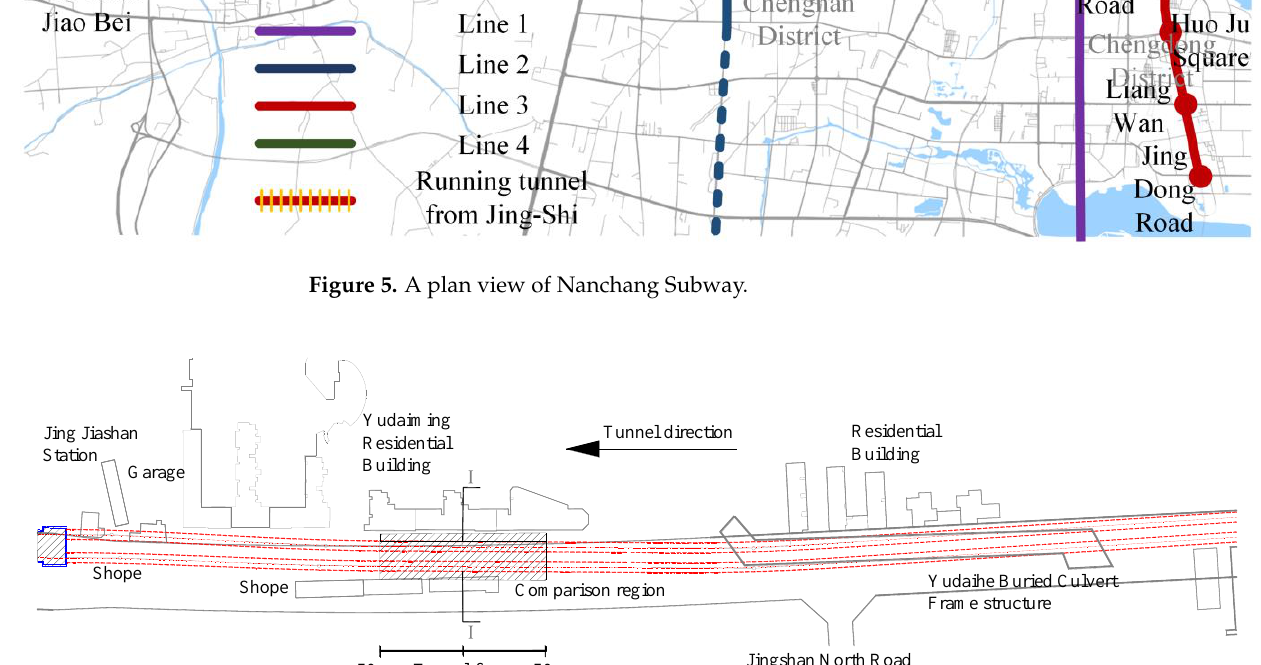
Figure 7. Monitoring section Ⅰ-Ⅰ. 3.2. Calculated Deformation of Ground Surface and Pipeline